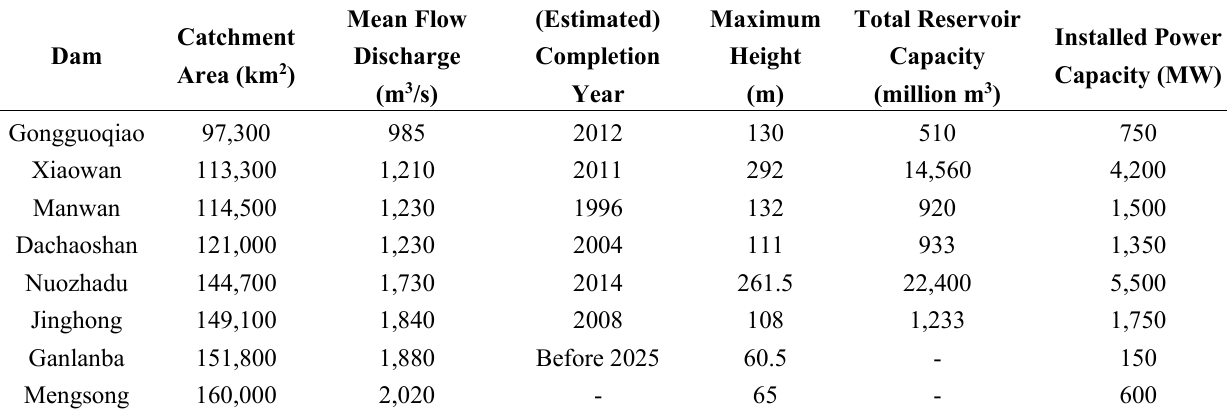
Table 1. China’s 8-dam cascade along the upper Mekong River (Lancang